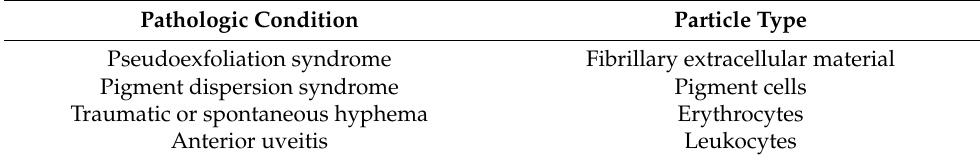
Table 1. Pathologic conditions and their corresponding particulate